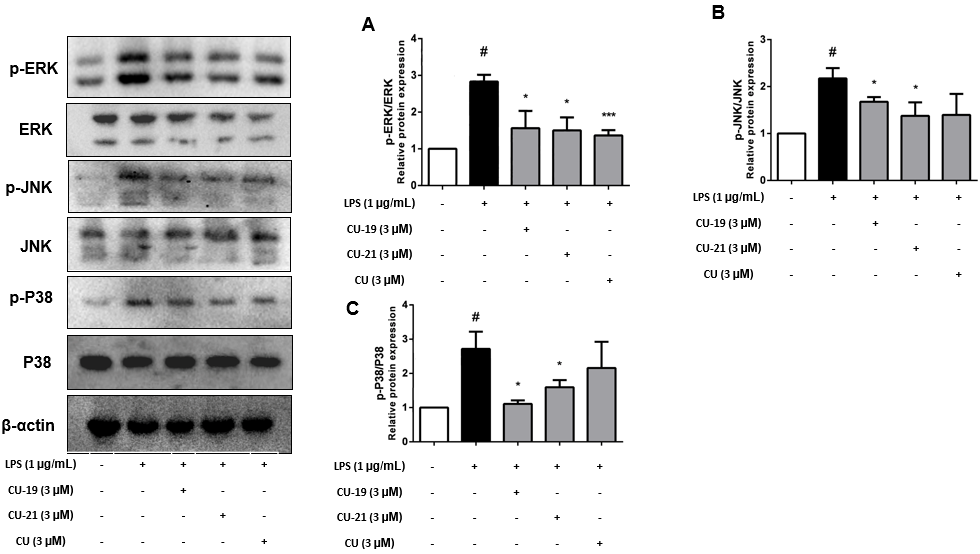
Figure 6. CU-19 , CU-21 and CU inhibited LPS-induced activation of MAPK signaling pathways in BV2 cells. BV2 cells were pretreated with CU-19 , CU-21 and CU (3 μM) for 1 h, followed by stimulation with LPS (1 µ g/mL) for 24 h, then were subjected to immunoblot analysis using antibodies that specifically recognized phosphorylated and non-phosphorylated p38, JNK, ERK. Results were the mean ± SD, n = 3; # p < 0.05 vs. control; * p < 0.05, *** p < 0.001 vs. LPS